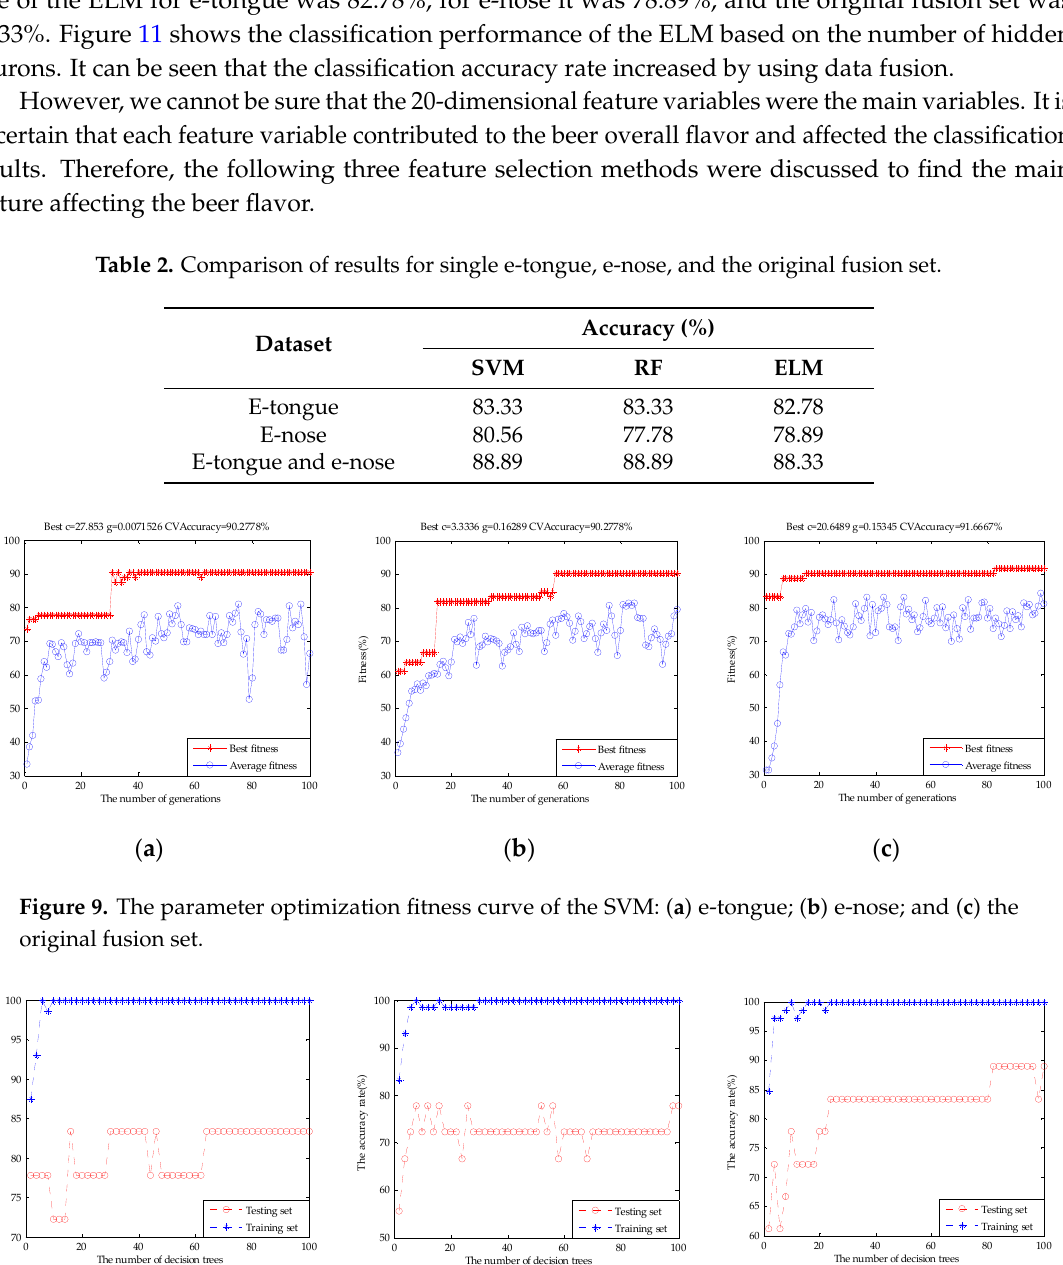
Table 2. Comparison of results for single e-tongue, e-nose, and the original fusion set.